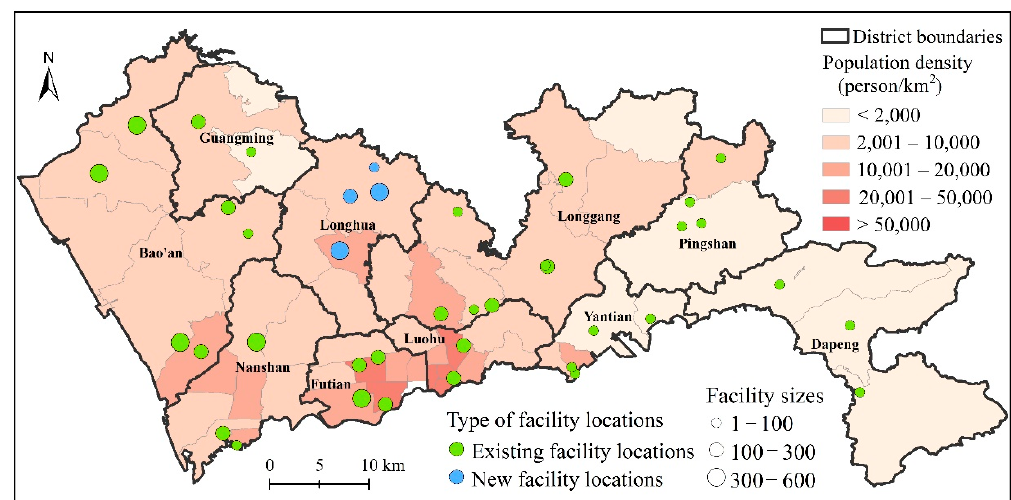
Figure 6. Optimized distribution of secondary healthcare facilities.